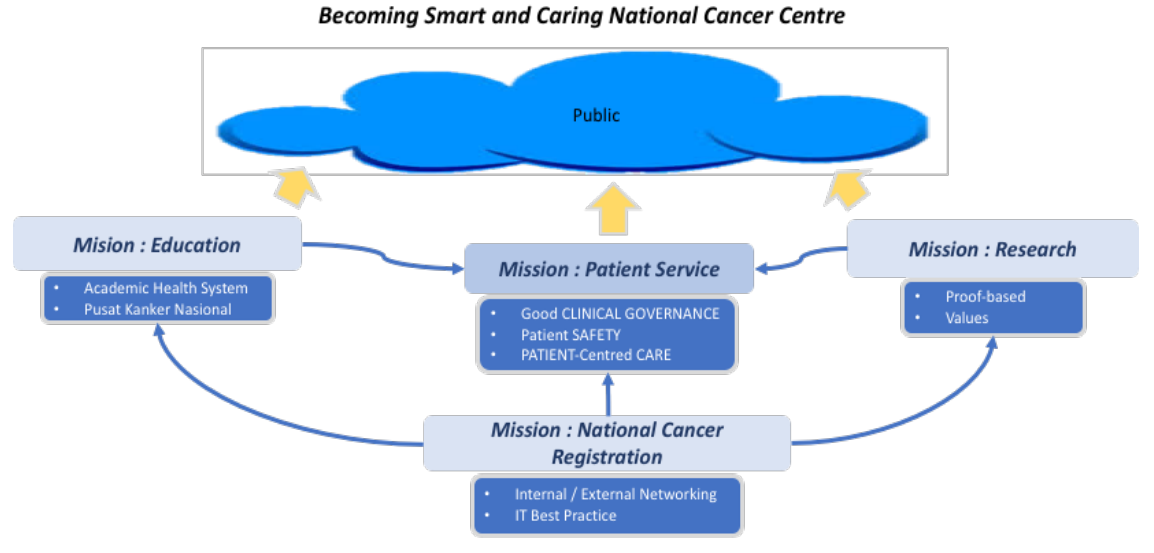
Figure 3. Vision and Mission RSK